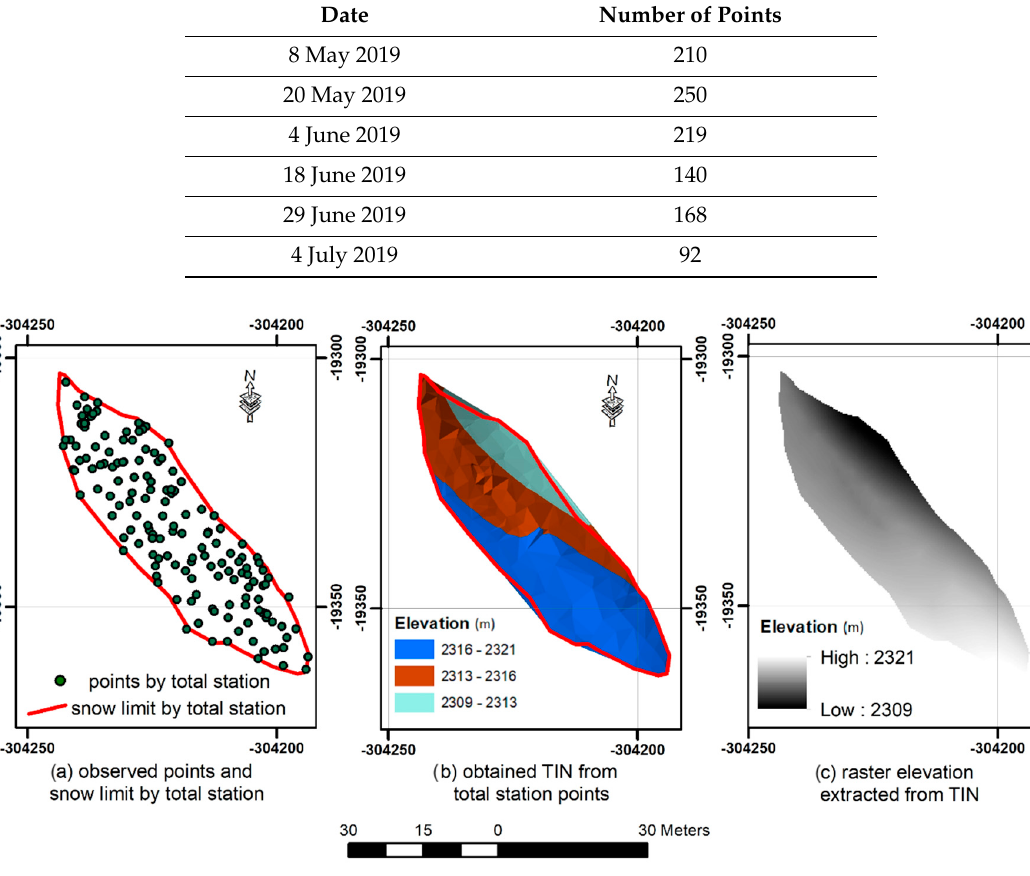
Figure 5. Steps to obtain a raster DEM from total station points.